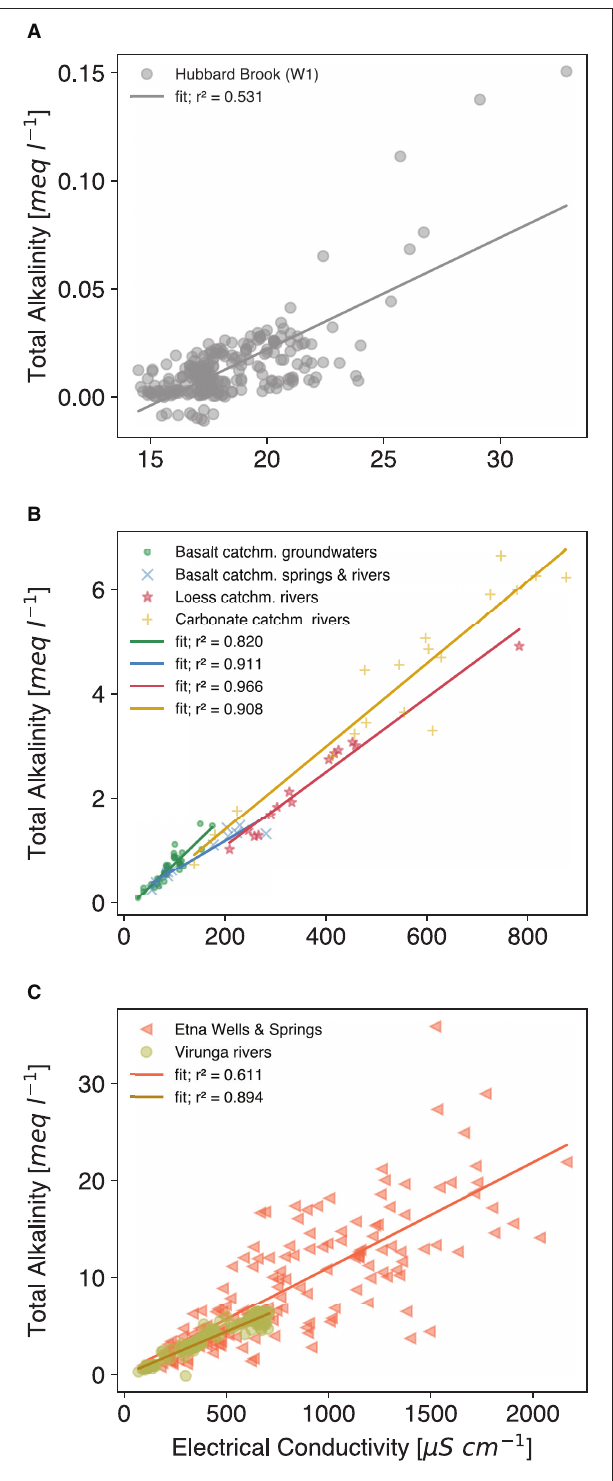
FIGURE 3 | Data fit: linear least squares fit with the coefficient of determination r 2 given in the legend. Regression parameters are provided in Supplementary Material S5 . (A) Data from Likens (2017) for watershed 1 of the Hubbard